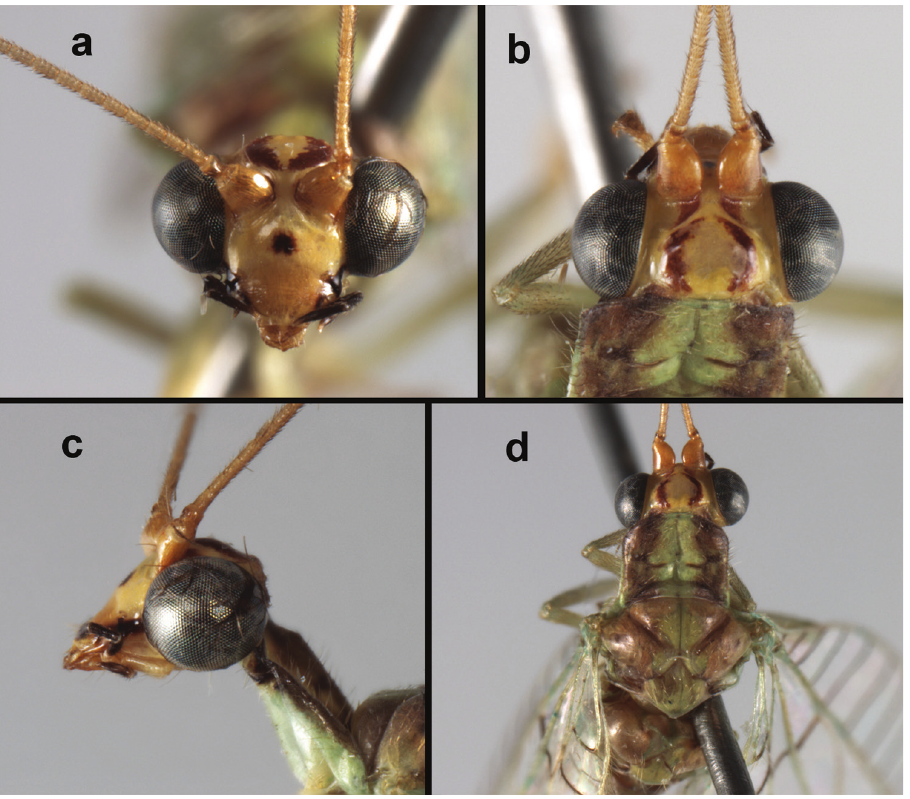
Figure 64. Ungla nigromaculifrons Sosa: External features, ( a ) head, frontal ( b ) head, dorsal ( c ) head, prothorax, lateral ( d ) head, thorax, dorsal (all: Venezuela, Táchira, UMSP; a, c male; b, d female).